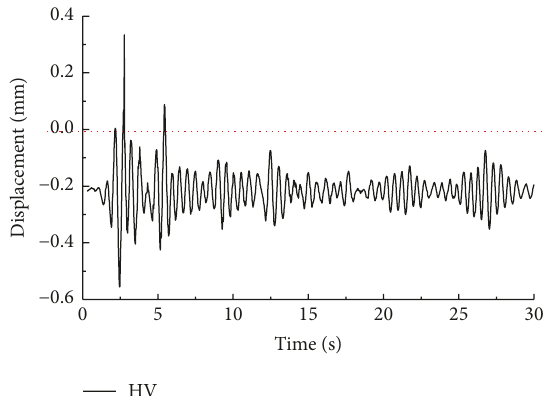
Figure 11: Vertical displacement at the corner of base mat under standard case (HV).